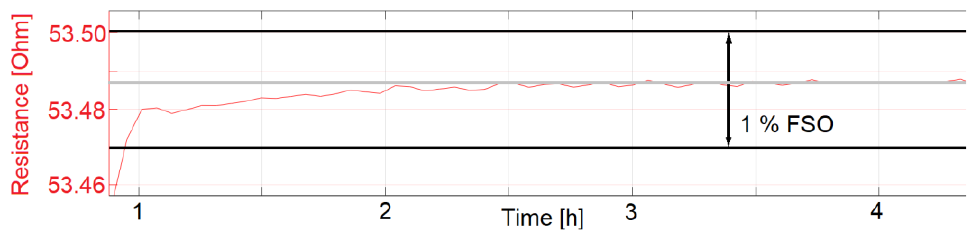
Figure 14. LCP 7 (with coating) start-up drift, zoomed to 1% FSO.